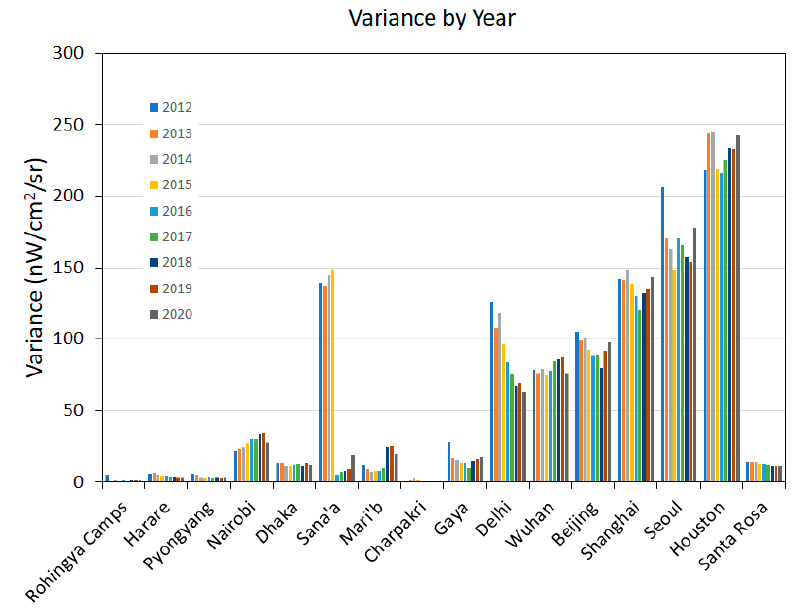
Figure 21. Picket-fence chart of the mean variance for each of the test sites by year.